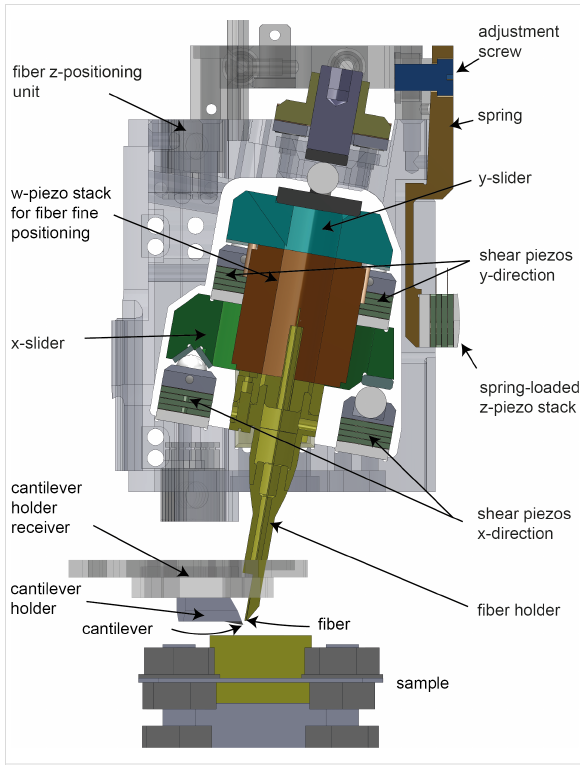
Figure 6: CAD sketch of the fiber z-positioning unit containing the x- and y-positioning unit. The assembly can be placed inside the cylin- drical instrument body. After tightening the adjustment screw, the spring-loaded z-shear piezo stack and, consequently, the z-shear piezo stack attached to z-positioning unit will be pressed towards the sapphire rails on the inside of the cylindrical instrument body.